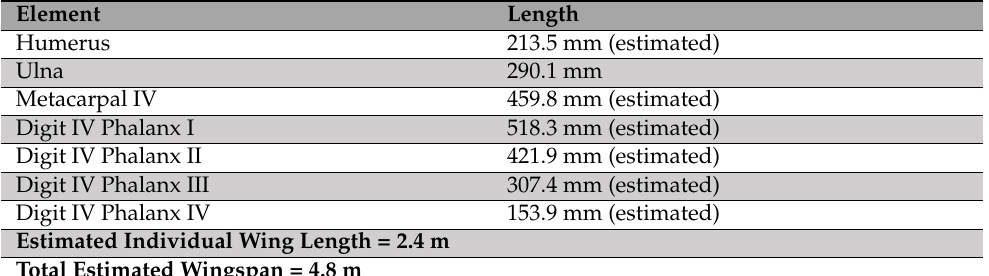
Table 2. Epapatelo otyikokolo , gen. et sp. nov. MGUAN-PA650-calculated humerus length and known MGUAN-PA650 ulna length measurements, with estimated additional individual wing element